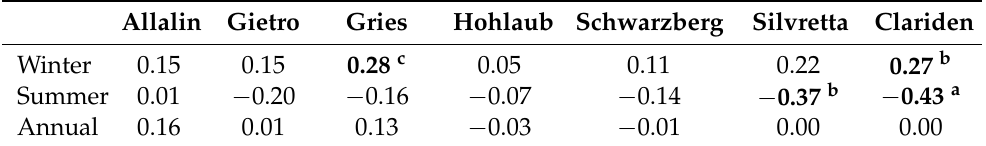
Table 5. Correlation coefficients of summer, winter, and annual precipitation versus Ba. Superscripts a–c indicate significance at p < 0.01, 0.05, and 0.10, respectively.